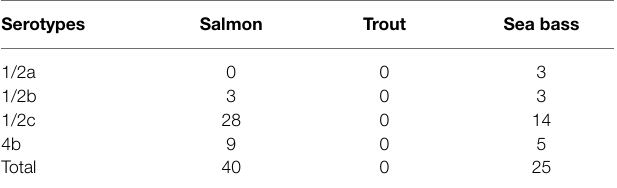
TABLE 3 | Serotypes of L. monocytogenes in cold-smoked fish. Serotypes